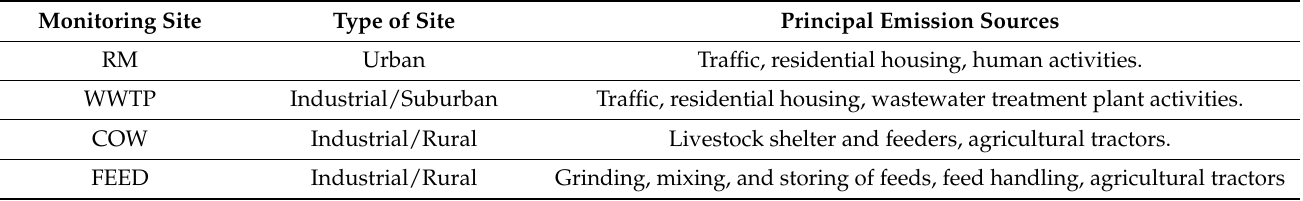
Figure 1. Location map of monitoring sites: one outdoor urban area (RM) and three outdoor industrial workplaces (WWTP, COW and FEED). Table 1. Description of the study